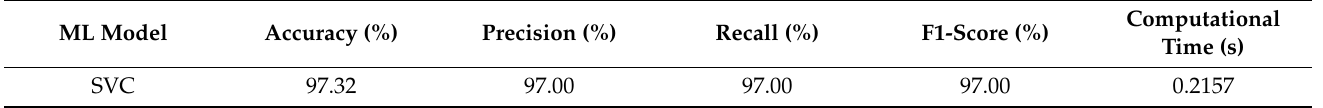
Figure 12. FDI evaluation: Confusion matrix of the svc model. Table 5. FDI performance evaluation and computational cost of the SVC classifier.